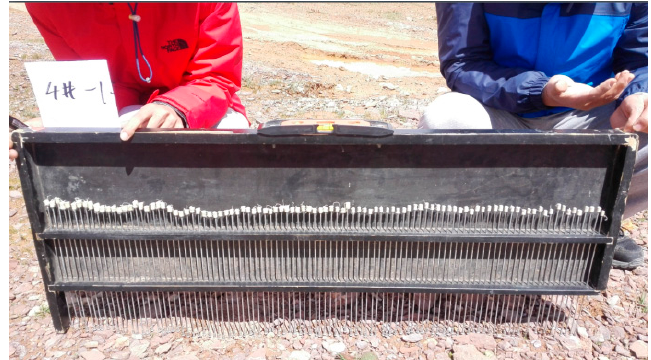
Figure 5. Example of a roughness profile with a 1 m long needle profilometer and a 1 cm interval between needles.